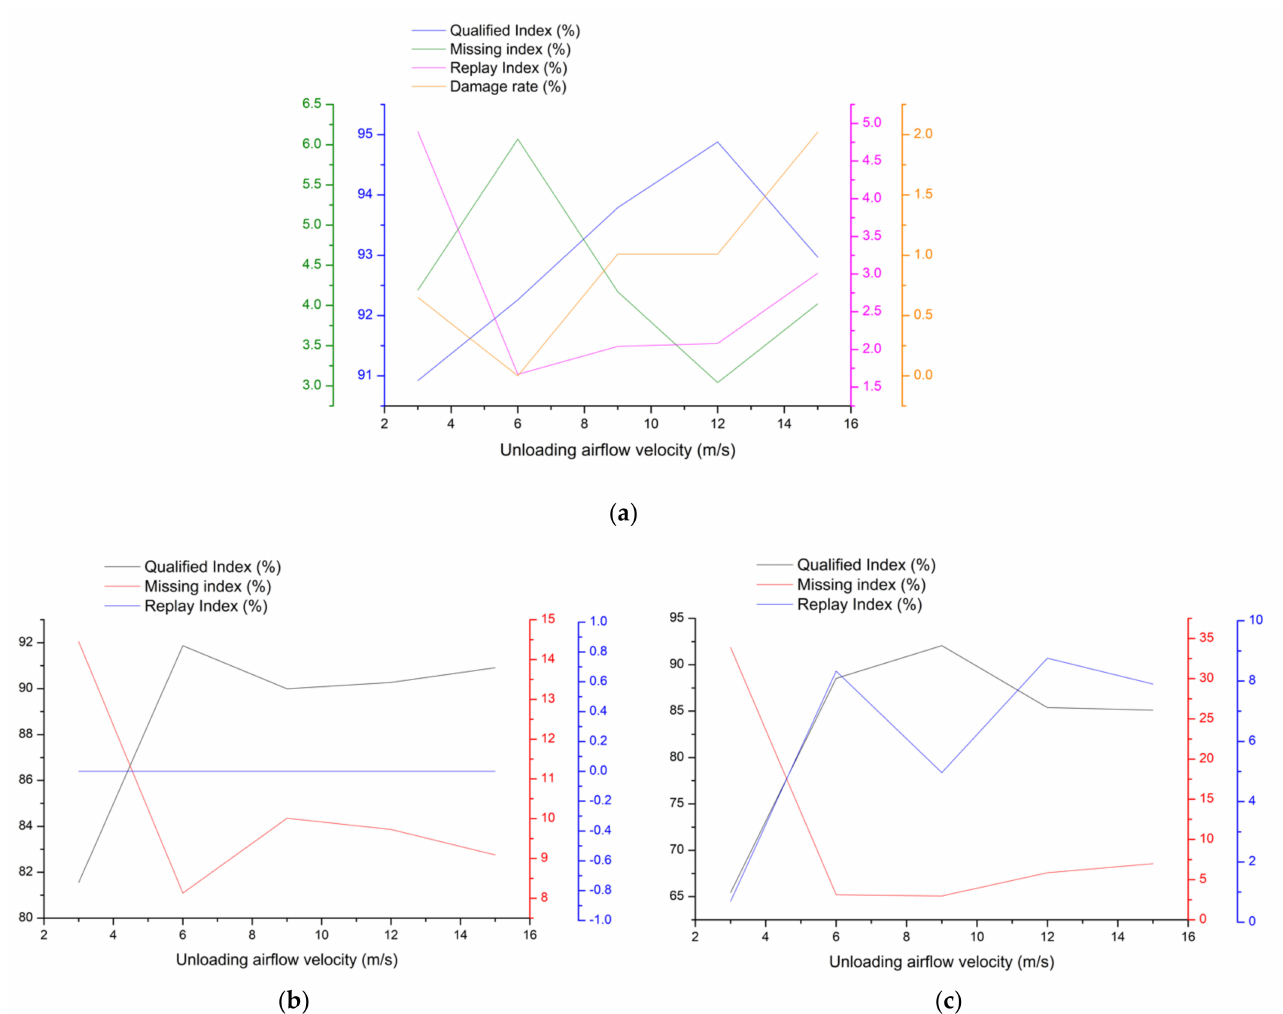
Figure 8. The relation curve between seed unloading airflow velocity and seed performance ( a ) Soybean; ( b ) Corn; ( c )